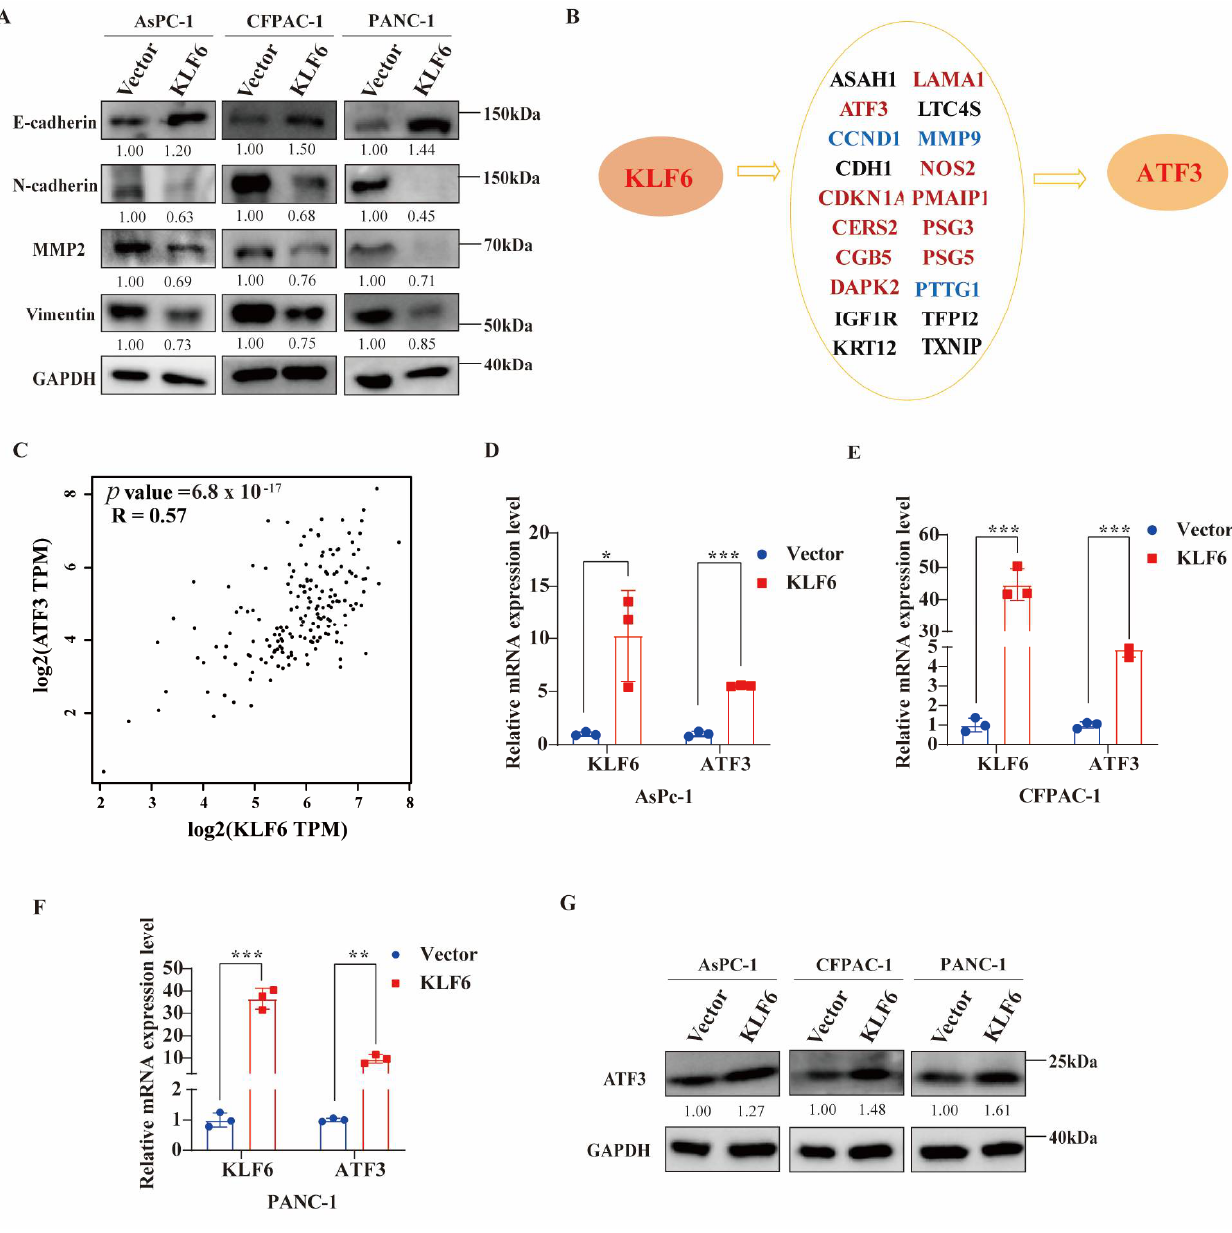
Figure 4. The EMT progression affected by overexpression of KLF6 and potential target genes of KLF6 in pancreatic cancer cells. ( A ) Western blot test results showing EMT protein markers, including E-cadherin, N-cadherin, MMP2, and vimentin, affected by overexpression of KLF6 in AsPc-1, CFPAC-1, and PANC-1 cells. ( B ) Potential targeted genes of KLF6 predicted by TRRUST database. Font in red refers to genes upregulated by KLF6; font in blue refers to genes downregulated by KLF6. ( C ) The correlation between KLF6 and ATF3 by GEPIA2 tool. ( D – F ) The mRNA ATF expression levels of ATF3 after overexpression of KLF6. Data represent mean ± SD; n = 3. * p < 0.05, ** p < 0.01, *** p < 0.001. ( G ) The protein ATF expression levels of ATF3 after overexpression of KLF6.